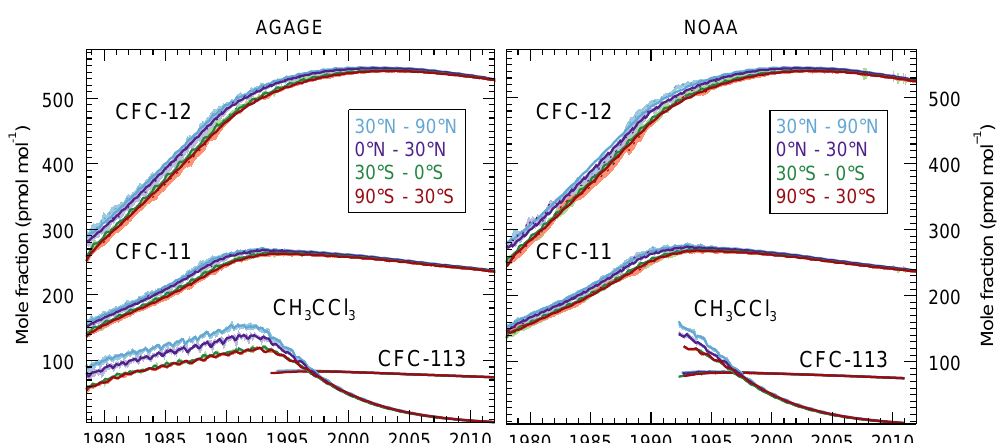
Fig. 2. Model prediction of AGAGE and NOAA CFC-11, -12, -113 and CH 3 CCl 3 mole fractions in each semi-hemisphere (solid lines). Dotted lines and the surrounding shaded areas show the measurements and the model-measurement uncertainty limits (1-sigma). Uncertain- ties include measurement repeatability and subsampling errors, along with model representation uncertainties, but not network calibration